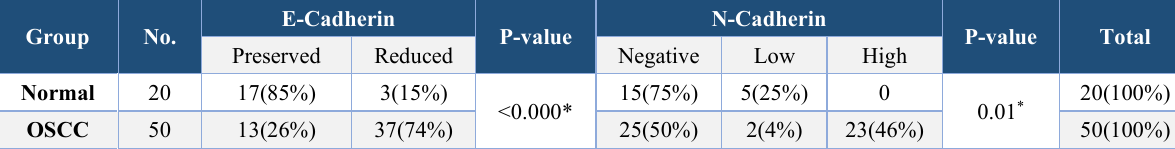
*Significant- Mann-Whitney